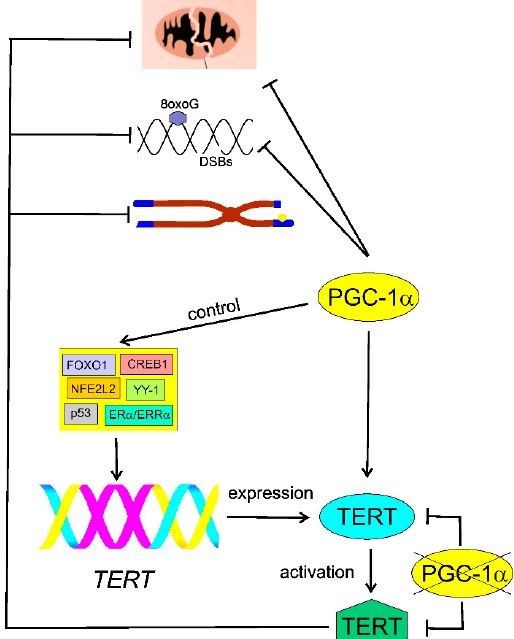
Figure 5. Inhibitory feedback loop between peroxisome proliferator-activated receptor gamma coactivator 1 alpha (PGC-1 α ) and the catalytic subunit of telomerase (TERT). PGC-1 α stimulates TERT, which ameliorates damaged/dysfunctional mitochondria, inhibits DNA damage, and improves shortened or otherwise damaged (yellow hexagon) telomeres (blue boxes) at chromosome (brown) ends. Deletion of PGC-1 α results in an increased level of 8-hydroxydeoxyguanosine (8oxoG), a marker of oxidative DNA damage, and other oxidative modifications of DNA bases, as well as DNA strand breaks (DSBs). PGC-1 α deletion inhibits expression and activity of telomerase. This effect may be underlined by the loss of control of PGC-1 α in transcription factors FOXO1 (forkhead box O1), NFE2L2 (nuclear factor, erythroid 2 like 2), p53, CREB1 (cAMP responsive element binding protein 1), ER α (estrogen receptor 1)/ERR α (estrogen receptor related alpha), and YY-1 (YY1 transcription factor), targeting the promoter (purple) of the TERT gene. The lack of PGC-1 α (crossed) may inhibit both the expression of the TERT gene and its product